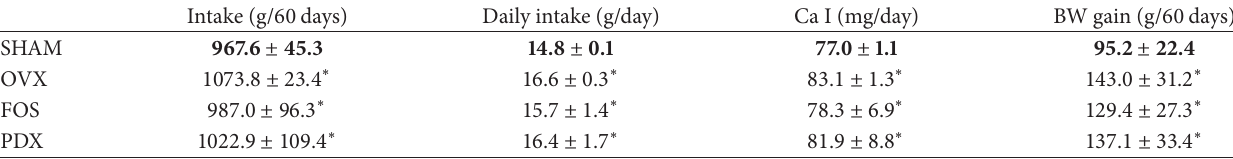
Table 2: Food consumption throughout the study, daily intake, daily Ca intake (Ca I) and body weight (BW) gain.